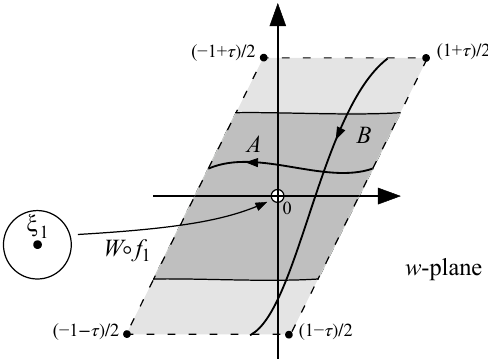
Figure 5 . Picture of the propagator contribution to the tadpole diagram in the uniformization coordinate w . The dark grey region represents the part of the torus created by the cubic vertex, and the light grey region is the part of the torus created by the propagator tube. The horizontal curves separating these regions is the image of the boundary of the (cid:24) 1 and (cid:24) 1 local coordinate disks. For $ > $ min these curves are very nearly straight lines. The external state of the tadpole is inserted in the (cid:24) 1 local coordinate, and then mapped to the origin of w plane with h 1 = W (cid:14) f 1 . For $ > $ min the image of the local coordinate is very